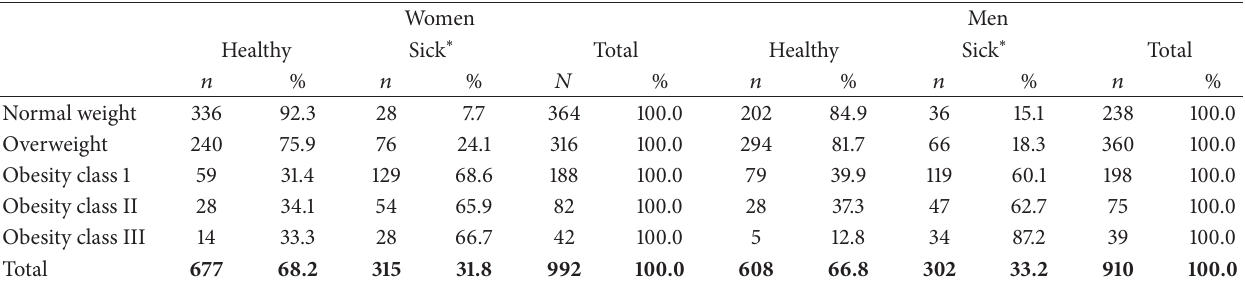
Table 5: Distribution of the population according to BMI and Metabolic Health Status. Maracaibo City Metabolic Syndrome Prevalence Syndrome, 2013.